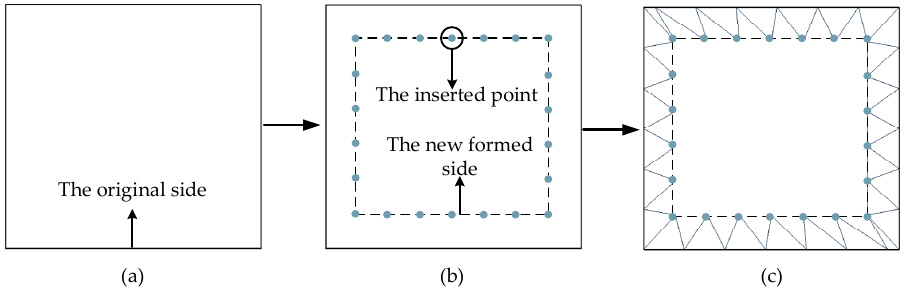
Figure 8. Schematic diagram of the side processing of the four-sided region: ( a ) the original four- sided region; ( b ) the formed sides and the points inserted on them; ( c ) the result of the polygon triangulation of the new and old sides.